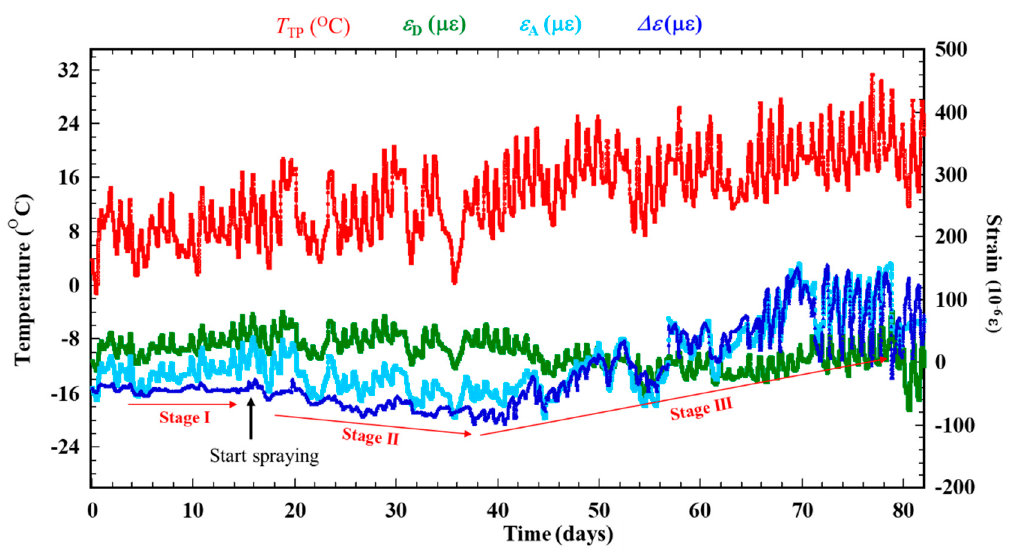
Figure 7. Result of a dry–wet cyclic exposure with ACSSM.